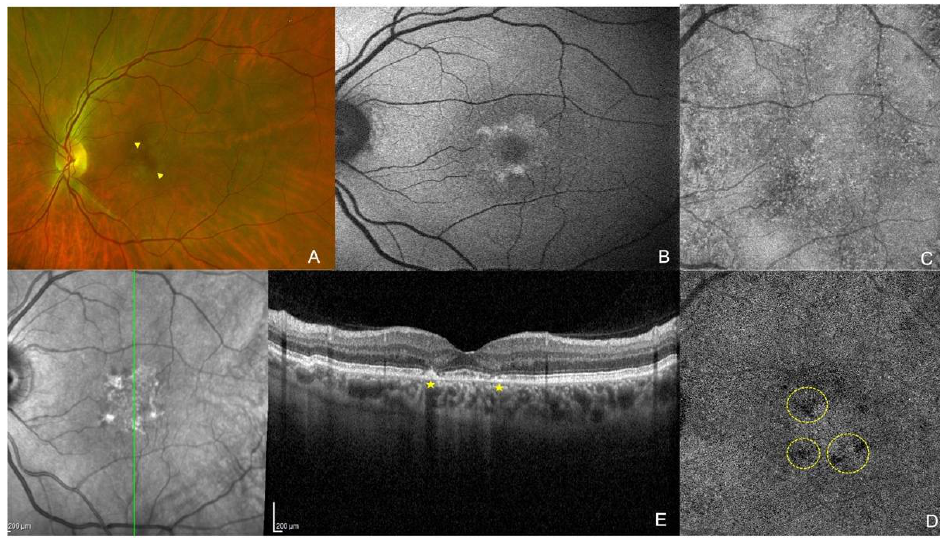
Figure 1. Multimodal imaging of a left eye of a patient presenting with hydroxychloroquine retinopathy: ( A ) color retinal photography revealing yellowish annular lesions in the foveal area (yellow arrowheads); ( B ) Fundus autofluorescence showing macular hyperautofluorescent ring delimitating the macular lesions; ( C ) choriocapillaris en-face structural image in swept-source optical coherence tomography (SS-OCT) angiography and en-face flow image; ( D ) showing flow deficits (yellow circles); ( E ) Spectral Domain OCT vertical B scan showing parafoveal outer retinal layers and ellipsoid disruption defining the typical flying saucer sign (yellow stars).